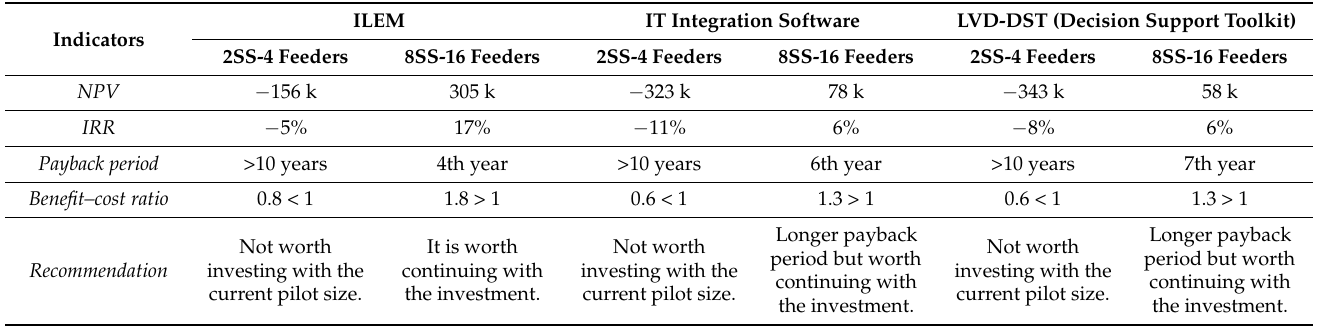
Table 6. Summary of CBA for willingness to pay scenario of the three RESOLVD software. 2SS-4 feeders represent current pilot size, and values are rounded to the nearest thousand